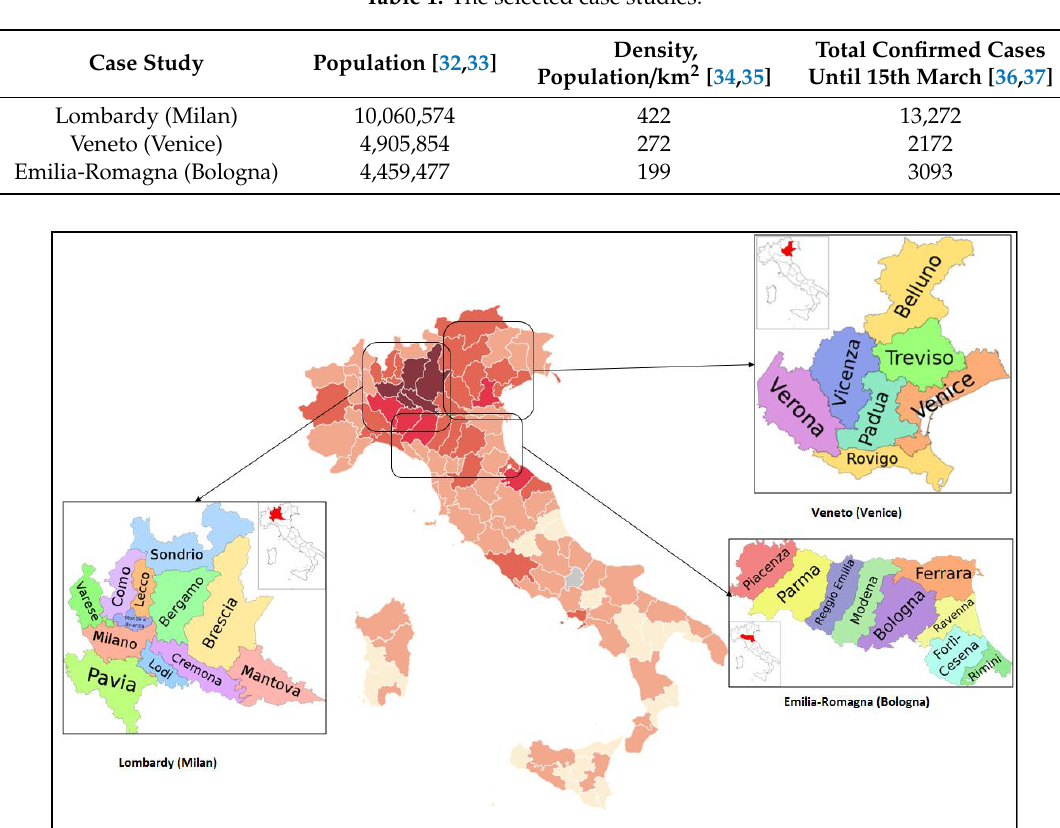
Table 1. The selected case studies.